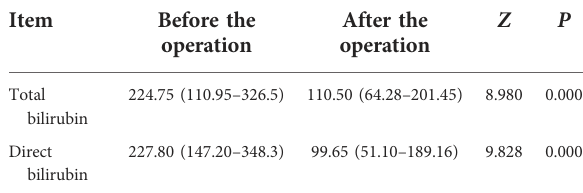
TABLE 1 Liver functions in 180 patients before and after the operation [M(Q1, Q3), μ mol/L].